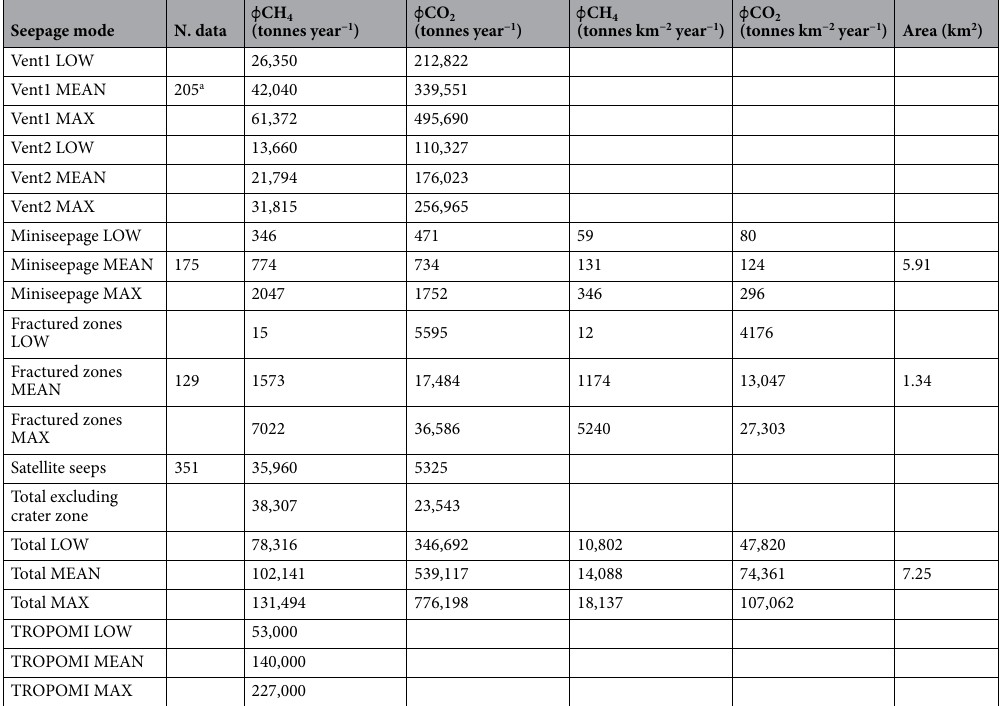
Table 1. CH 4 and CO 2 fluxes released to the atmosphere from the four Lusi degassing systems (two vents in the crater zone, miniseepage, fractured zones and satellite seeps) estimated by ground-based measurements. a Number of vent plume measurements; = estimated gas flux. The accuracy of the flux measurements completed with the portable fluximeter inside the embankment zone (miniseepage, fractures zones and ϕ satellite seeps) is ±